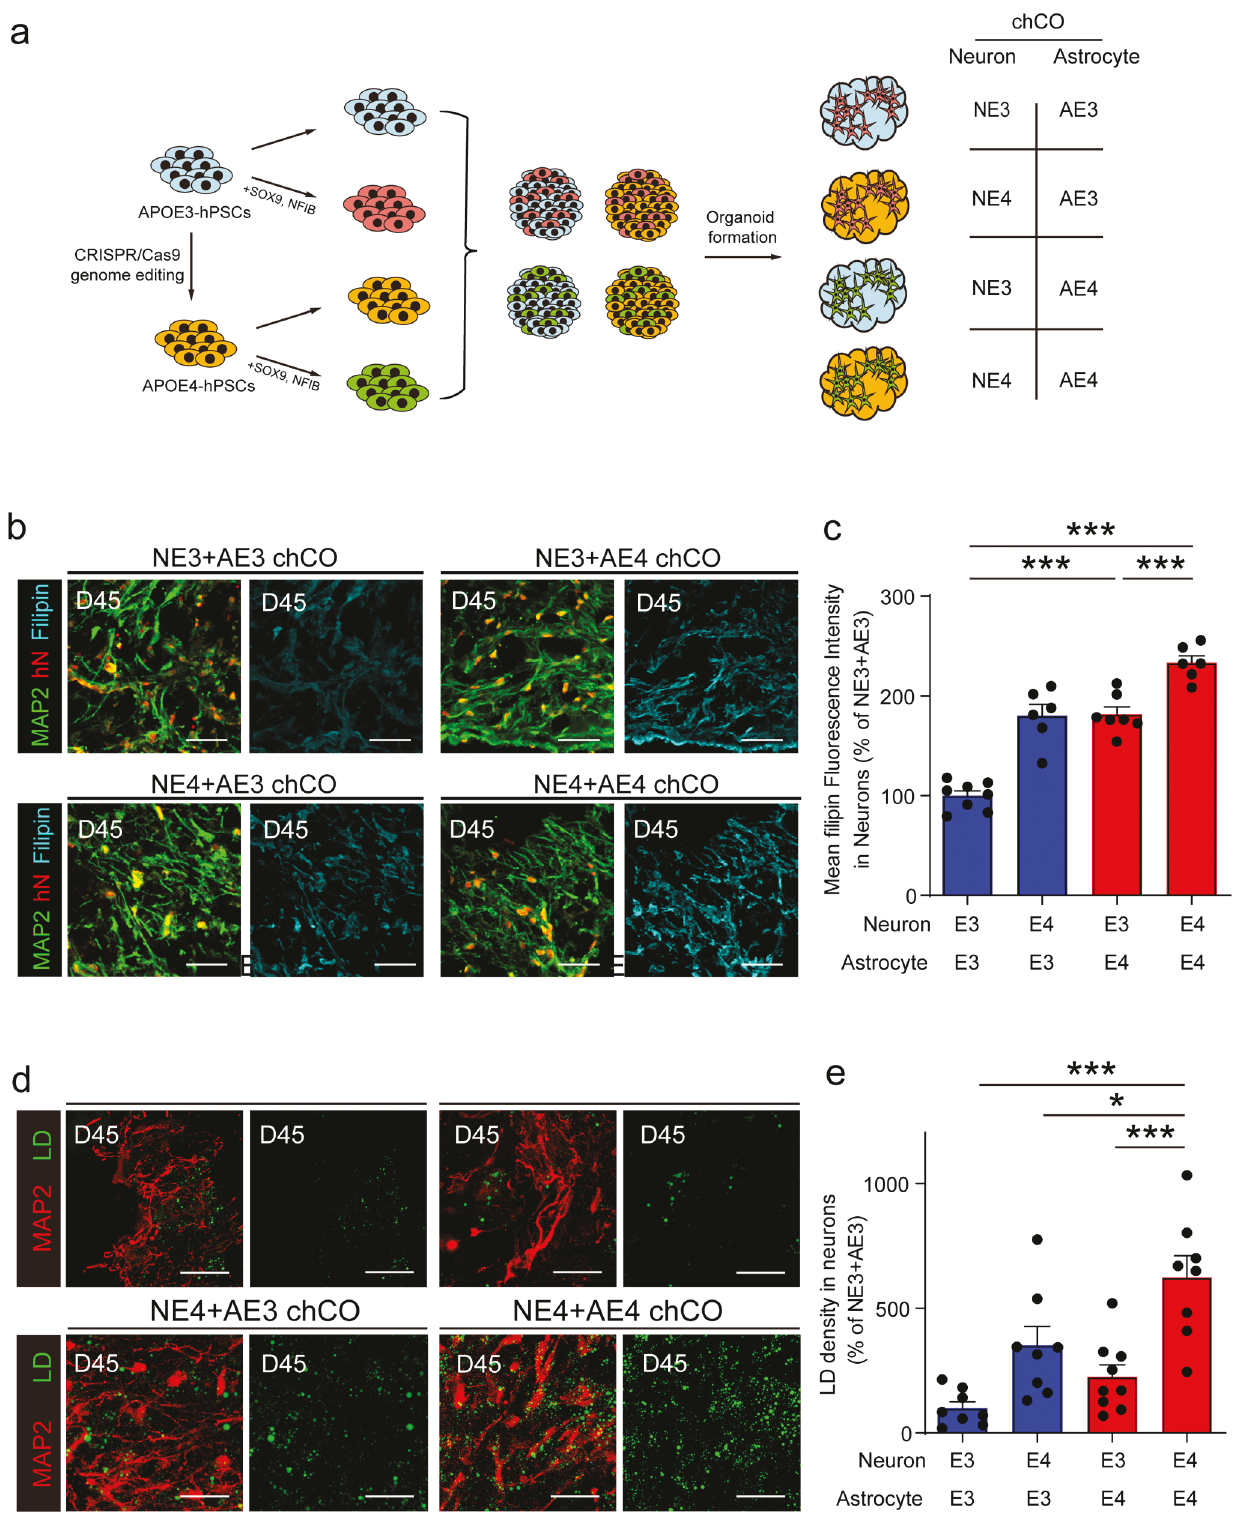
Fig. 3 Astrocytic and neuronal APOE4 elevated cholesterol and lipid droplet levels in neurons. a Experiment procedure for generation of chCOs with neurons and astrocytes carrying APOE3 or APOE4 allele. b Representative images of different chCOs on D45 stained with fi lipin, MAP2, and human nuclei. Scale bar: 50 µm. c Quanti fi cation of mean fi lipin fl uorescence density in the neurons. Data represent the mean ± s.e. m. ( n = 6 – 8 organoids, from three different batches; *** p < 0.001). d Representative images of chCOs and control hCOs on D45 stained with LipidTox and MAP2. Scale bar: 30 µm. e Quanti fi cation of the lipid droplet density in the neurons. Data represent the mean ± s.e.m. ( n = 8 – 9 organoids, from four different batches; * p < 0.05, *** p < 0.001)